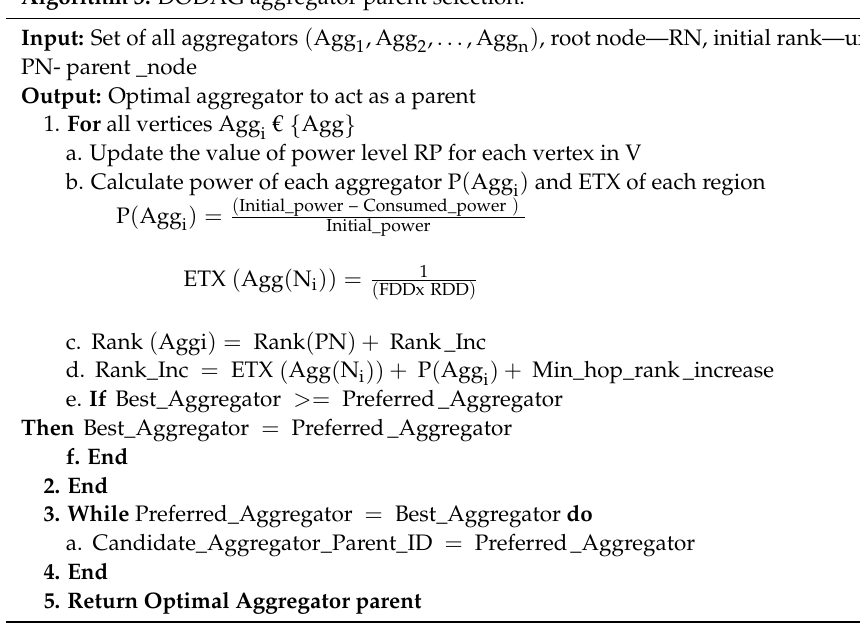
Algorithm 3: DODAG aggregator parent